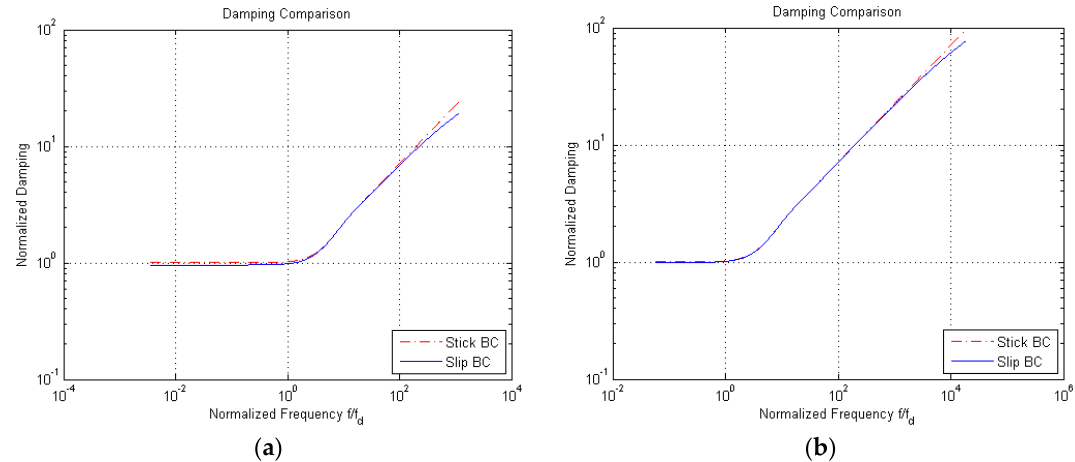
Figure 7. Engaged solution, ( a ) 𝐻 = 3 μm and ( b ) 𝐻 = 12 μm : normalized damping at varying frequency 𝑓 , for both stick and slip BCs.